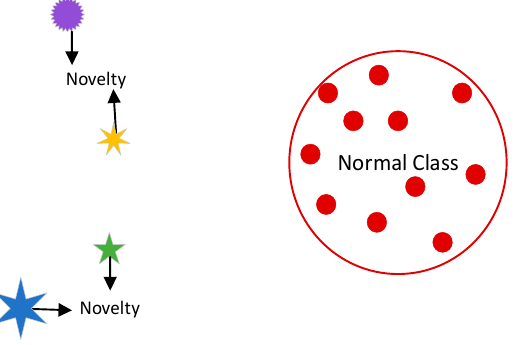
Figure 9. Visualization of novelty detection concept.